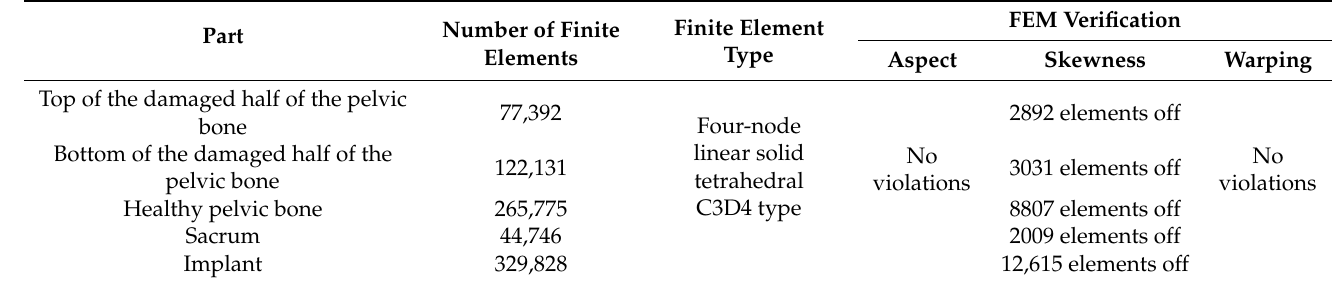
Table 1. Characteristics of the finite element model.